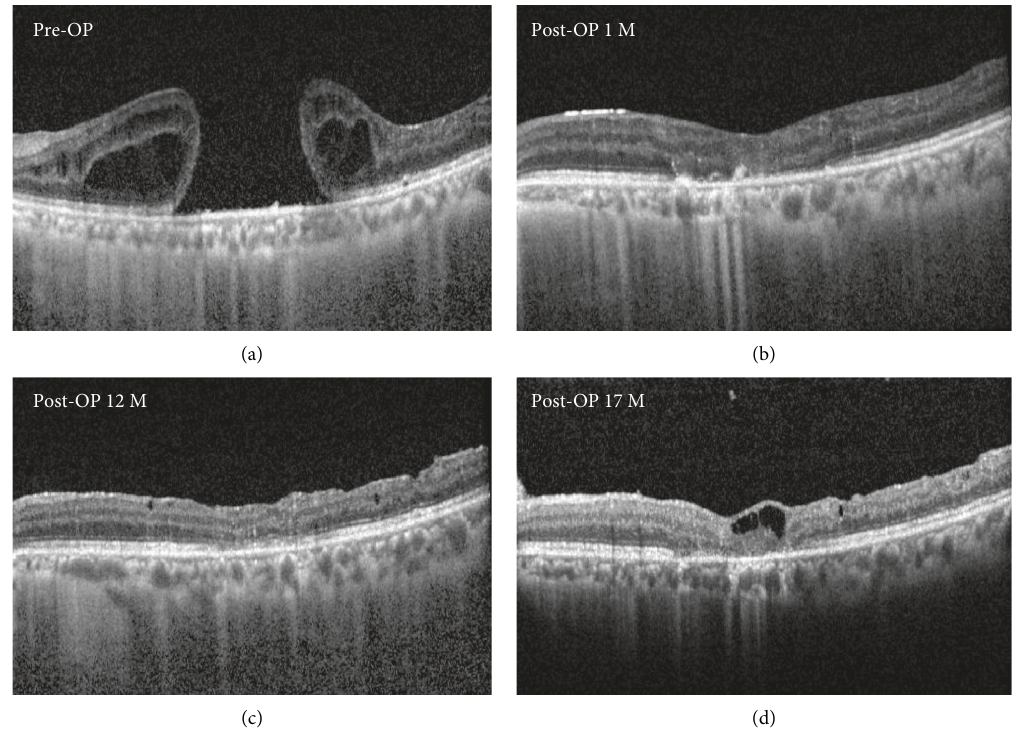
Figure 3: OCT findings after autologous retinal transplantation (ART) of case 5. (a) Baseline OCT showing a large macular hole with a diameter of 2209 μ m. The BCVA was 20/2000. (b) One-month follow-up OCTof the same patient. It showed retinal flap integration with the edges of the macular hole. (c) 12-month follow-up OCT. It showed further reconstitution of the ELM and EZ bands. The BCVA was 20/100. (d) Seventeen months postoperation, the inner retinal cystic change was seen on OCT, but BCVA was